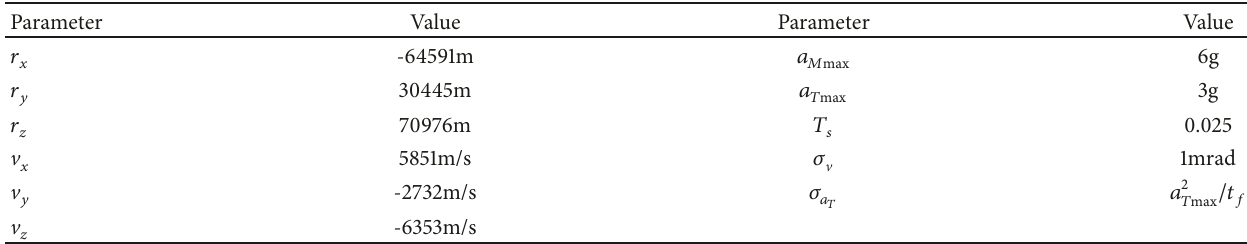
Table 1: Initial parameters and values of the